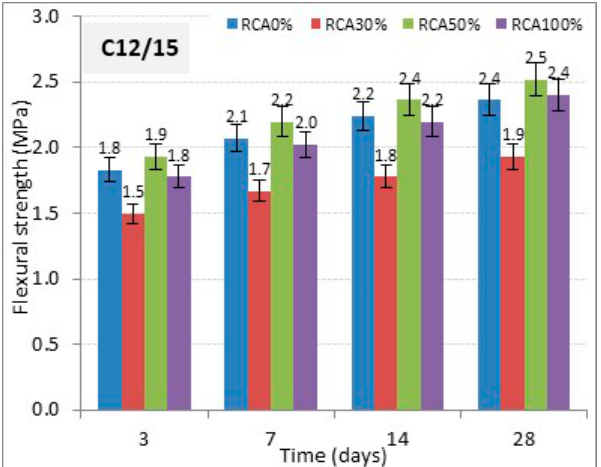
Figure 8. Effect of RCA content on the flexural strength development for C12/15 concretes. Figure 8. E ff ect of RCA content on the flexural strength development for C12 / 15